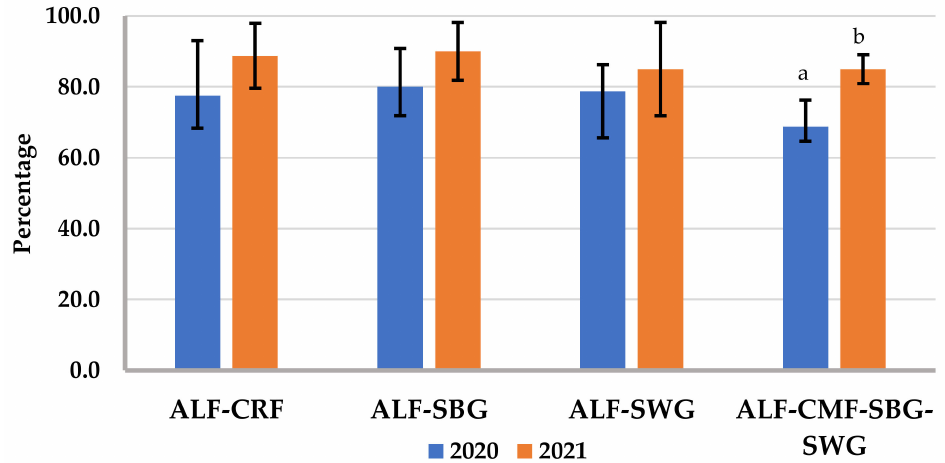
Figure 2. Bar chart representing mean and standard deviation (SD) of stand establishment of ‘Halo’ alfalfa and grass mixtures at Clavet, Saskatchewan, Canada over 2 yrs (2020–2021). Note: ALF, alfalfa cv. ‘Halo’; CMF, creeping meadow foxtail cv. ‘Garrison’; SBG, smooth bromegrass cv. ‘Radisson’; SWG, slender wheatgrass cv. ‘Revenue’. a,b Bars with different letter within a treatment are different among years at p ≤